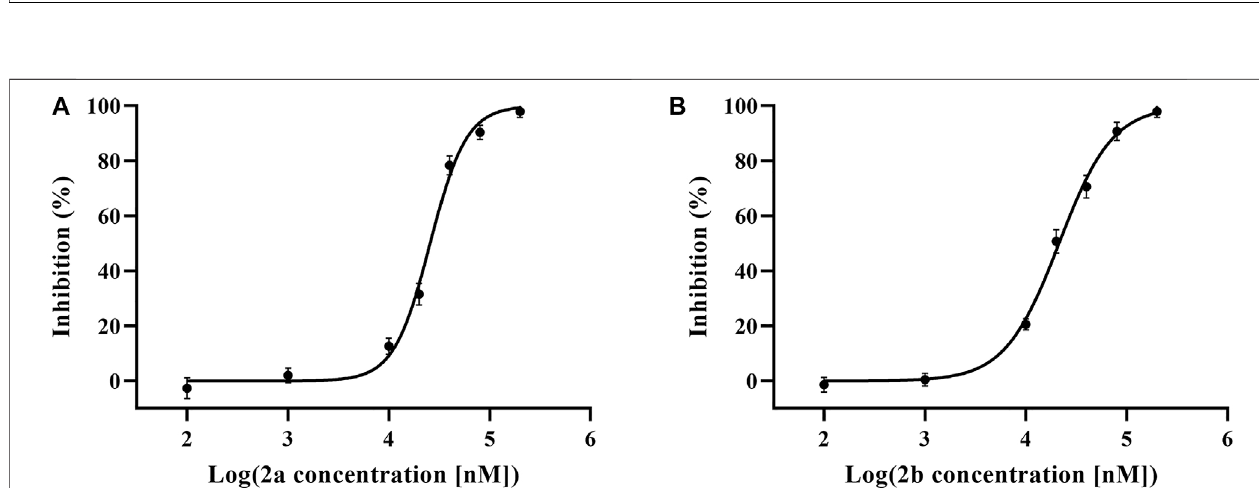
FIGURE 5 | L929 assay of compound 2 (A,B) in the presence of different concentrations ( n = 3).